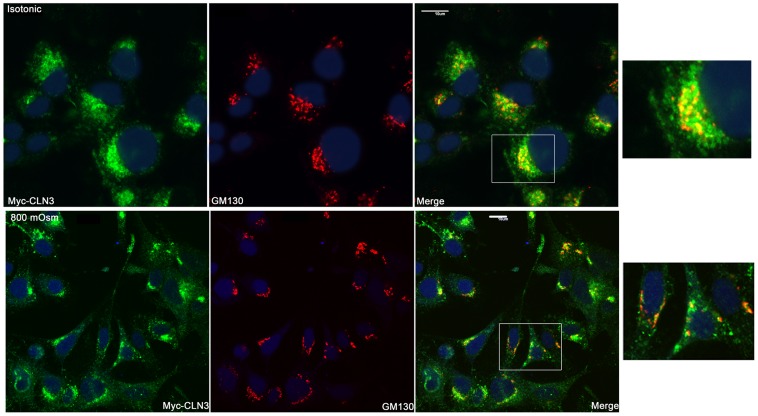
Osmotic stress decreases the Golgi localization of myc-CLN3.BHK clone 19 myc-CLN3-expressing cells were grown on poly-D-lysine coated coverslips either under isotonic (300 mOsm) or hyperosmotic conditions. Osmolarity was increased at 100 mOsm intervals to 800 mOsm by the addition of NaCl/urea. After being exposed to 800 mOsm for 24 hours, cells were fixed, permeabilized and immunofluorescently stained for the myc-tag (to detect myc-CLN3; green) and for the Golgi marker, GM130 (red). Under isotonic conditions myc-CLN3 is primarily in the perinuclear region with prominent Golgi localization. In the merged images yellow indicate the Golgi-localized myc-CLN3. Osmotic stress decreases the Golgi localization of myc-CLN3, and CLN3 appears in the whole cell body and in cellular processes. The white-framed areas of the merged images are enlarged at the right side of the figure to highlight the osmotic stress-induced changes in myc-CLN3 localization. Images were acquired with a confocal microscope. Scale bars indicate 10 µm.